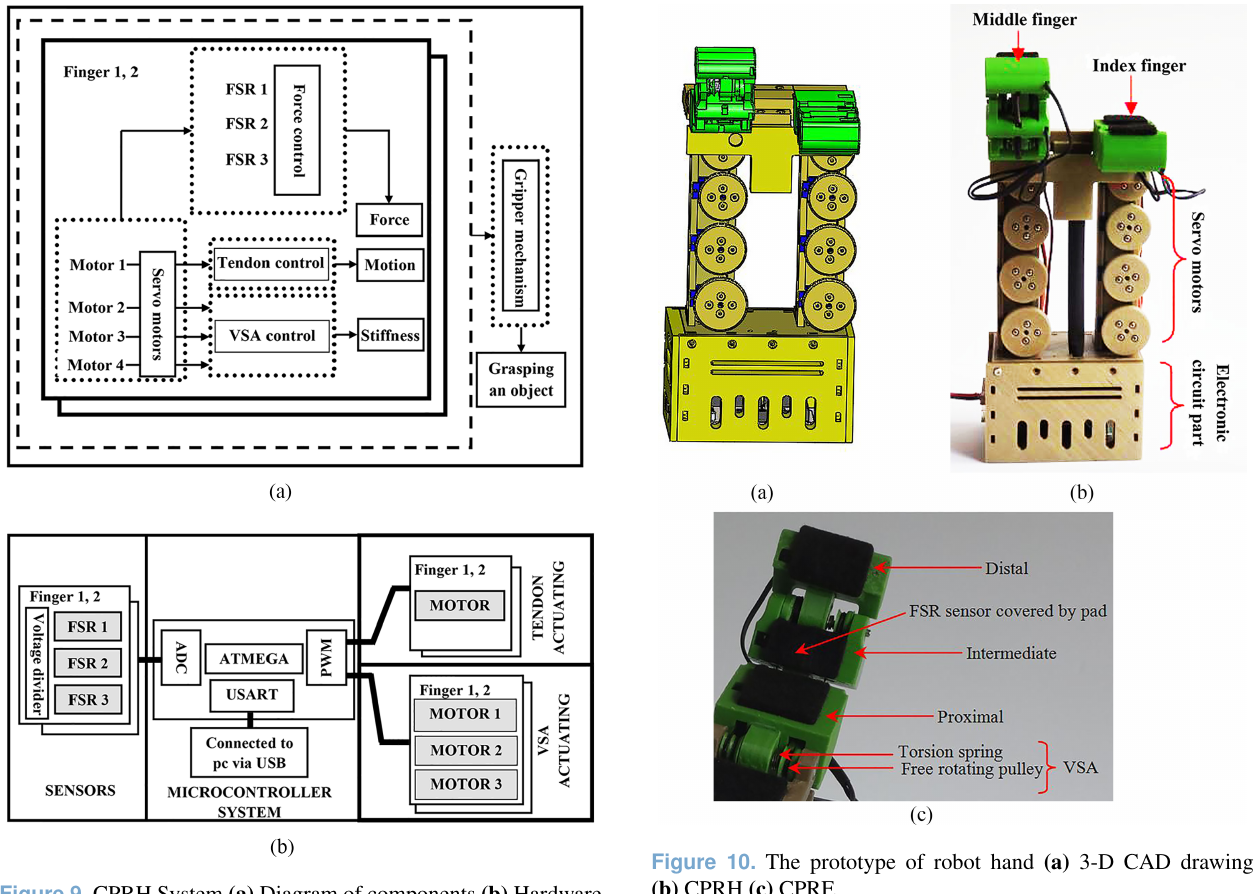
Figure 9. CPRH System (a) Diagram of components (b) Hardware architecture of the electronic and drive system.